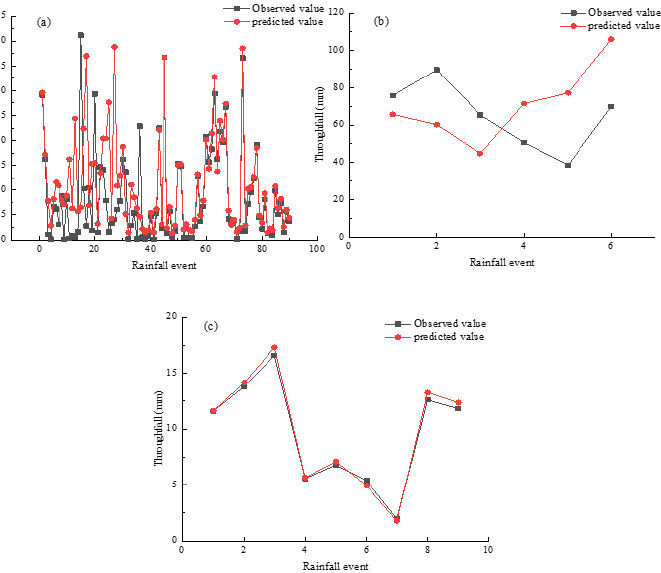
Figure 9. Comparison of observed and predicted throughfall of studied rainfall events. ( a ): Rainfall pattern A; ( b ): rainfall pattern B; ( c ): rainfall pattern C.